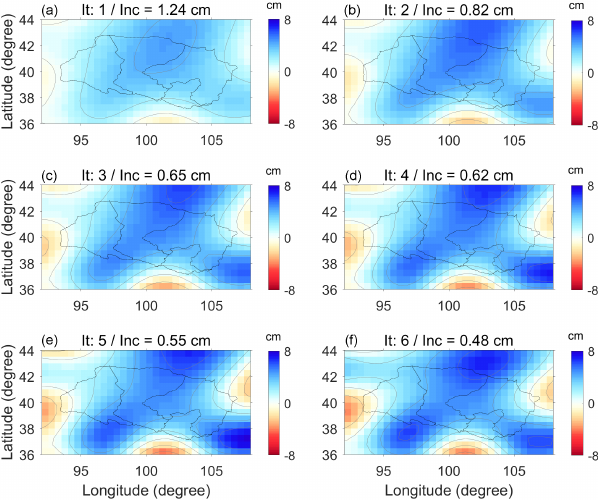
Figure 4. GRACE-derived TWS variation of October 2002. The signal restoration was applied to restore the signal mitigated by the applied Gaussian filter. After each iteration (It), the increment in each cell was computed. The procedure was stopped after six iterations, when the maximum increment (Inc) was lower than 0.5cm (f) .